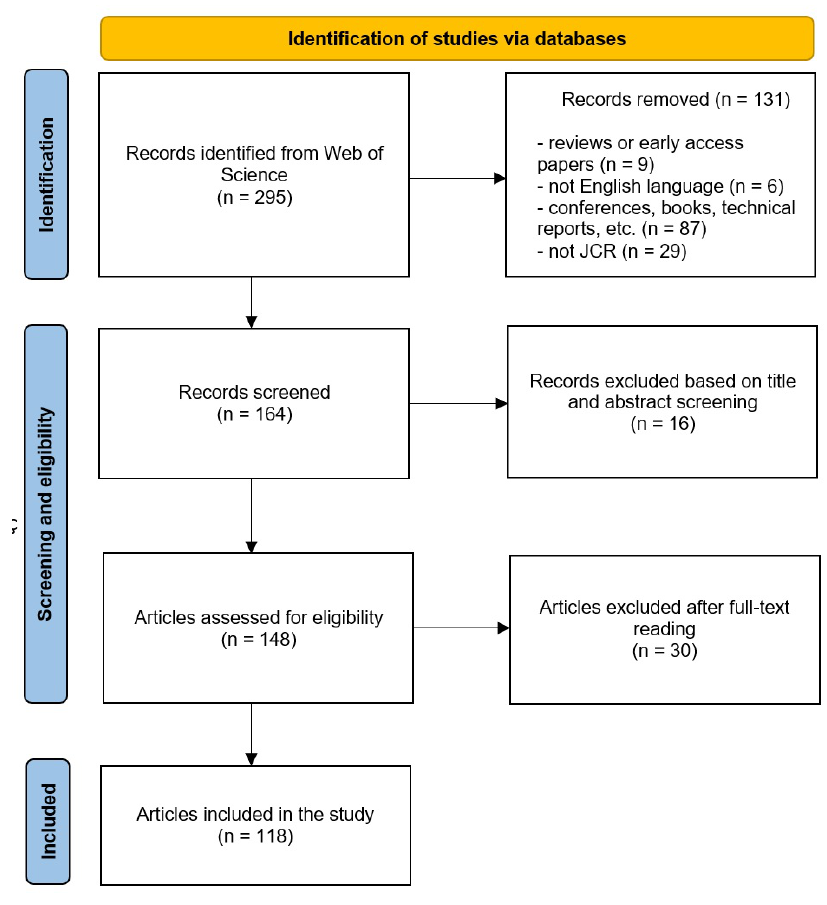
Figure 2. Flowchart of the research